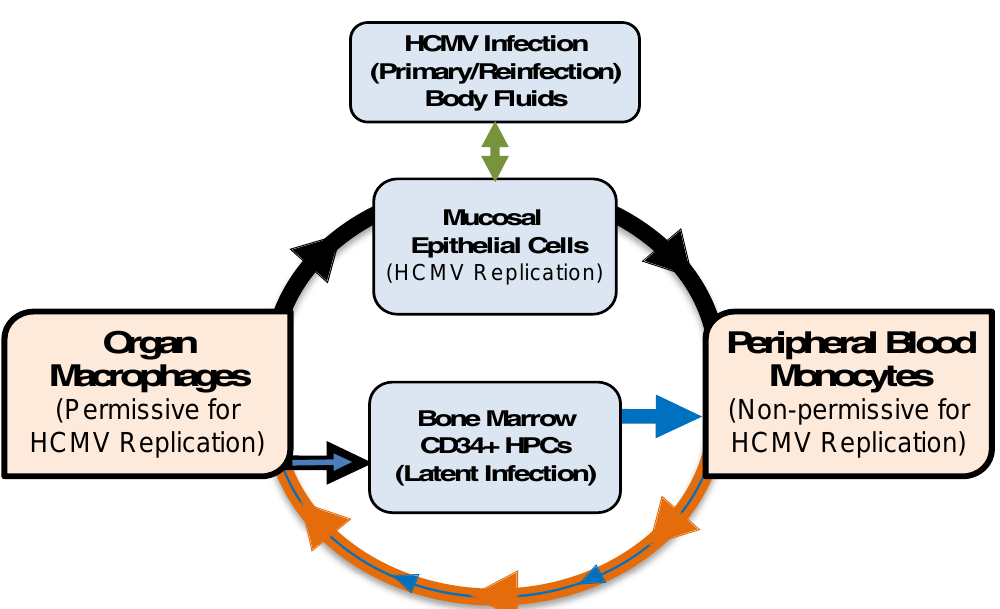
Figure 1. Model: Monocytes are a primary source of viral dissemination and persistence. Initially, epithelial cells (green arrow) of a naïve host are infected by virus shed in bodily fluids such as saliva, urine, or breast milk from an infected host [4]. Infection then spreads to the blood (black arrow) via an unclear mechanism (perhaps by dendritic cells) [42] and infects (at least enters) blood monocytes [1,4,43]. Next, infected monocytes extravasate, carrying the infectious virus, to peripheral tissue. The extravasation (and cellular activation) would primarily be mediated by activation of monocytes due to viral envelope (and possibly tegument) products, independent of new viral gene expression [30,34,36,37,44–46]. Infected monocytes would then differentiate (purple arrow) into naturally long-lived tissue macrophages [30,47] that are permissive for viral replication [1,4,23,26,38], allowing for replication of the original infectious virus carried into the tissue by monocytes [30,34,37,48]. This would ensure persistence within the host through chronic release of virus from macrophages (consistent with data from patients) [1], and the establishment of latency through the migration of infected blood monocytes into the bone marrow [22,23,49,50]. Reinfection of epithelial cells (black arrow) at “portals of virus exit” would allow spread to naïve hosts (green arrow). This process of viral spread utilizing myeloid cells initially occurs following primary infection. Reactivation of latent virus from CD34+ human progenitor cells (HPCs) (yellow/gold arrow) occurs throughout the life of the host, and thus serves as a long-term source of infected monocytes. Because these monocytes are latently infected (small yellow/gold arrow), one would expect aspects of the molecular consequences of latent infection of monocytes to be distinct from that seen following primary infection of monocytes. HCMV: human